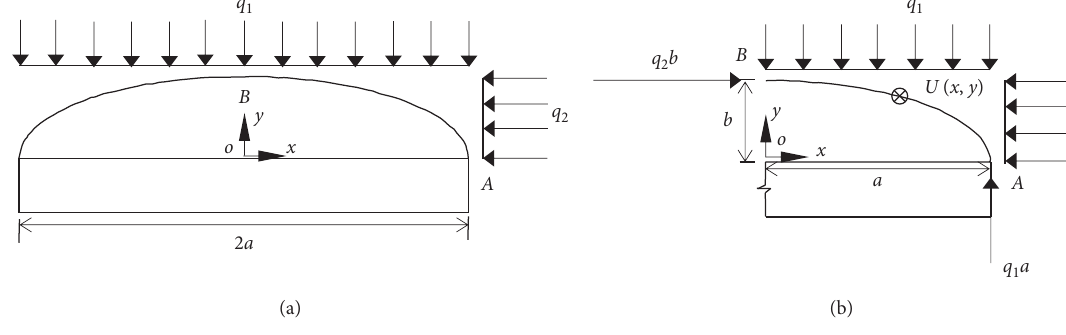
Figure 1: Schematic of trench arching.